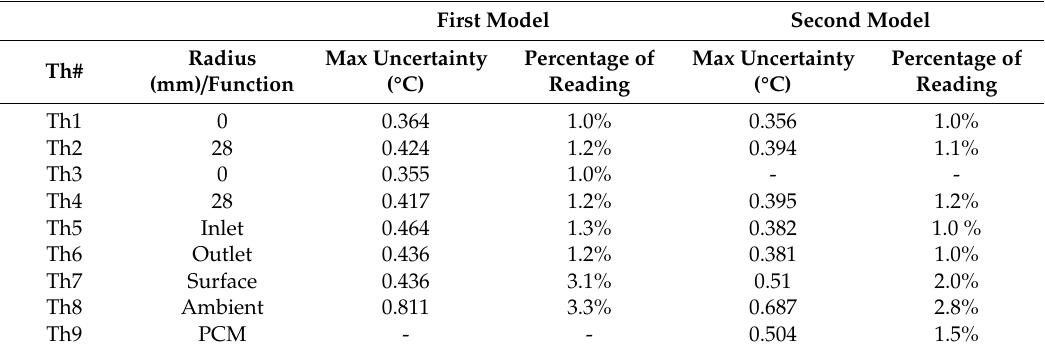
Table 3. Maximum thermocouples uncertainty for di ff erent